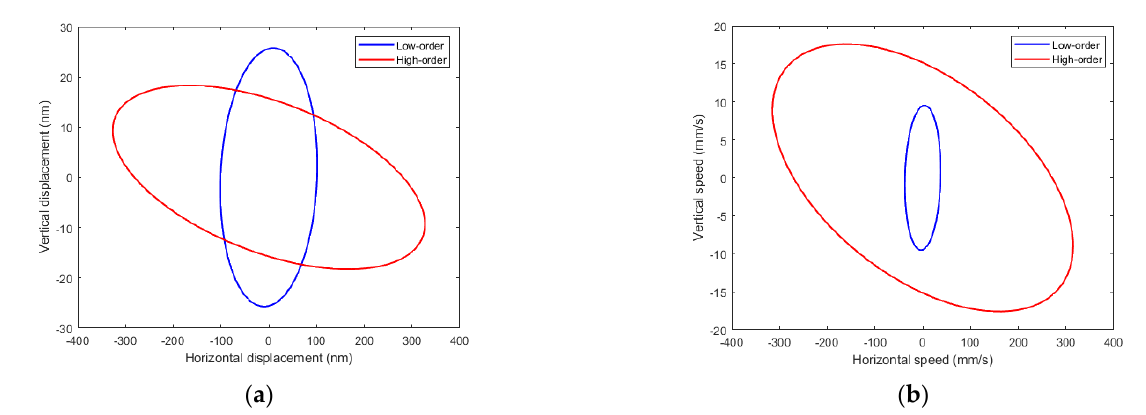
Figure 7. Simulated ( a ) displacement and ( b ) speed of the trajectory of the tip of the legs situated at the left side of the robot, for both the high-order and the low-order combinations.